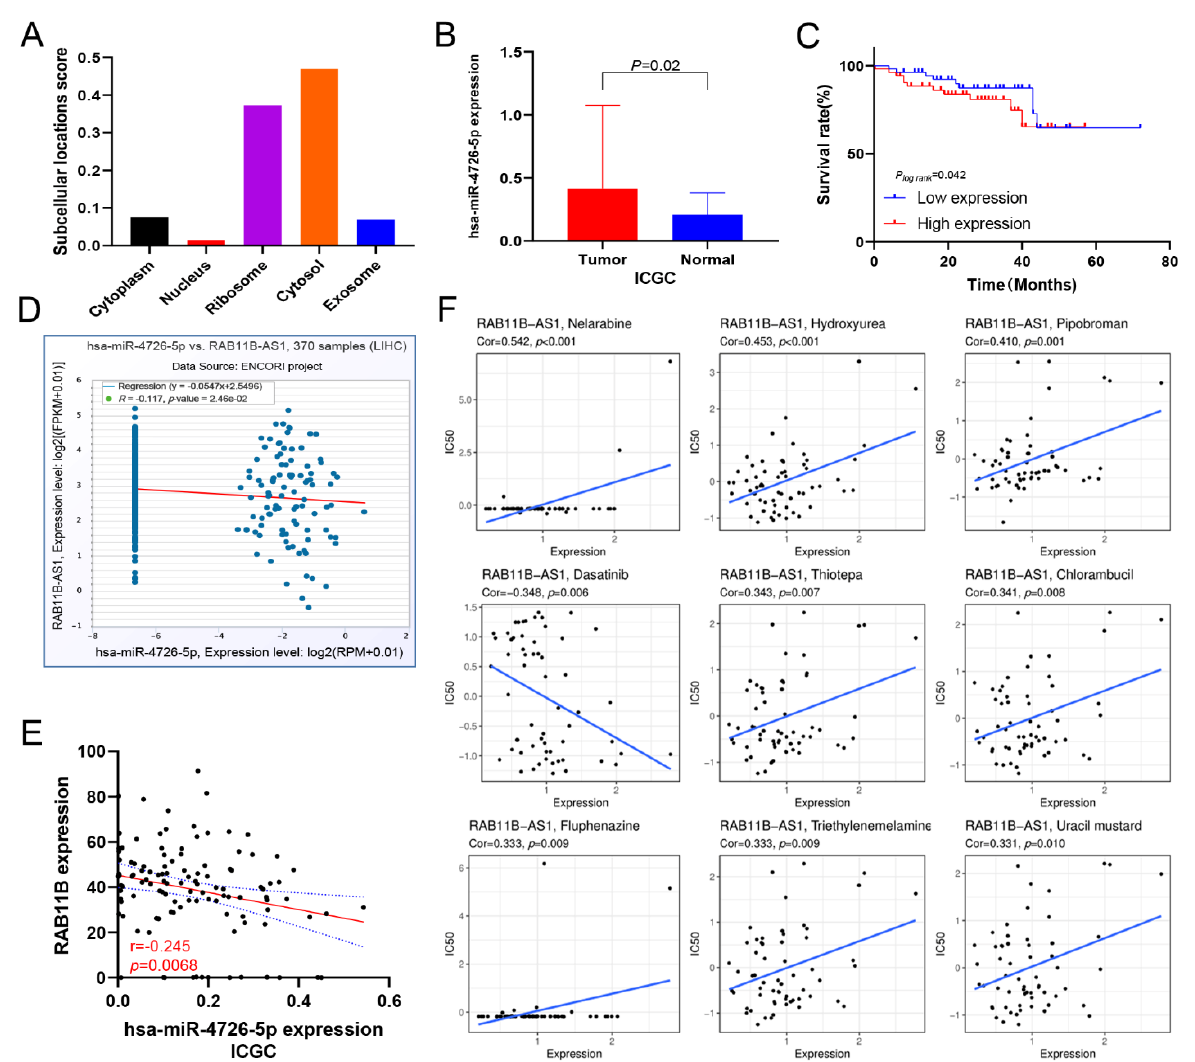
Figure 6. Prediction of potential candidate miRNAs and drug sensitivity analysis ( A ) The prediction of the subcellular localization of lnc-RAB11B-AS1 . ( B ) The expression status of hsa-miR-4726-5p in HCC tissues and normal tissues from ICGC. ( C ) Kaplan-Meier overall survival was analyzed according to hsa-miR-4726-5p expression in ICGC cohort. ( D ) The relationship between lnc-RAB11B- AS1 and hsa-miR-4726-5p expression in ENCORI database. ( E ) Correlation analysis of the expression of RAB11B and hsa-miR-4726-5p in 232 pairs of HCC tissues. ( F ) Relationship between lnc-RAB11B-AS1 and chemosensitivity to nine drugs.